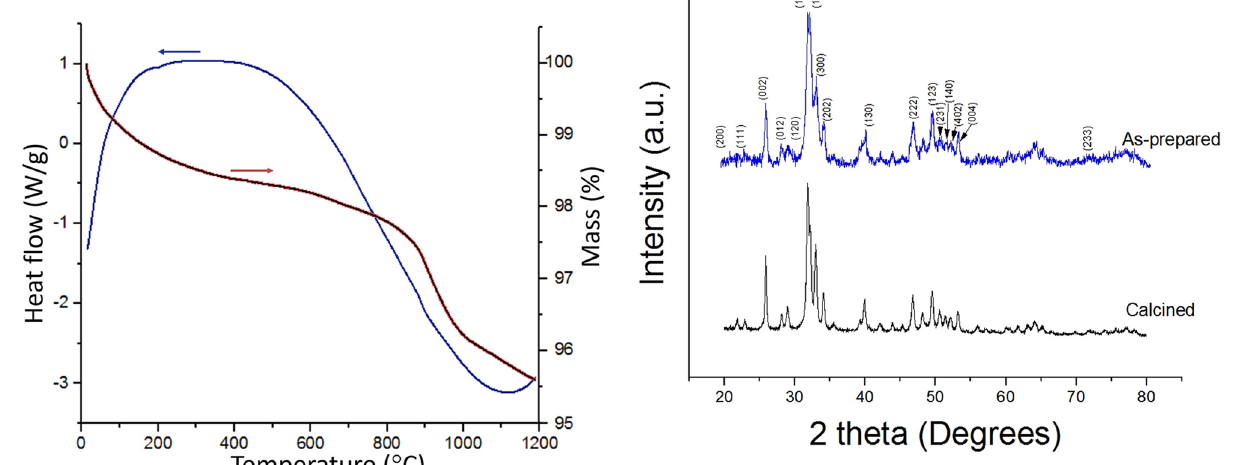
Figure 3: TG and DSC curves of the synthesized HA powder.